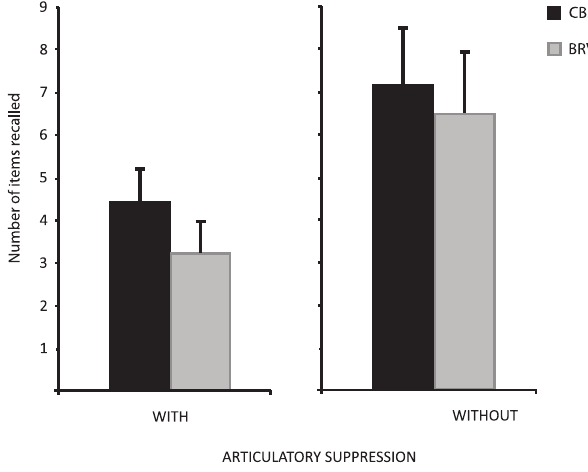
Figure 1. Results of the tactile task performed with and without articulatory suppression. Both groups performed similarly with no tory suppression was present, the CBS group performed better than the BRV